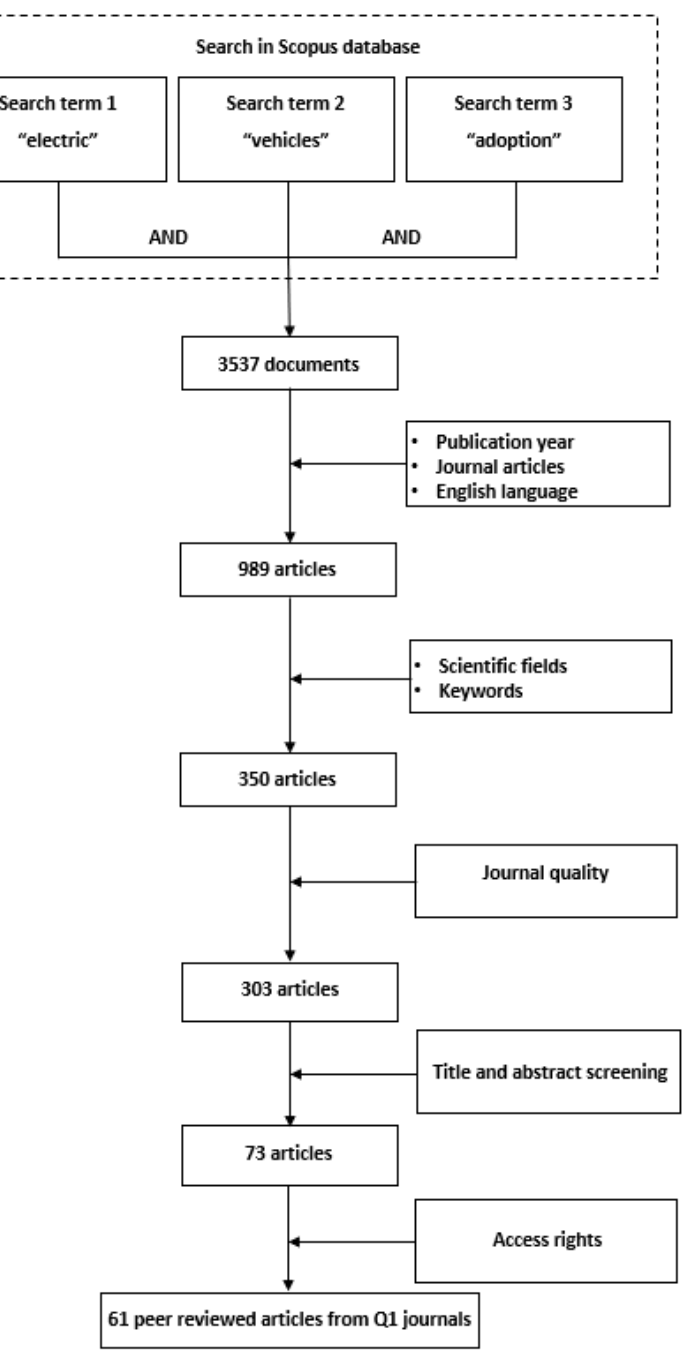
Figure 1. Workflow of the literature review methodology incorporating searching criteria and filters .